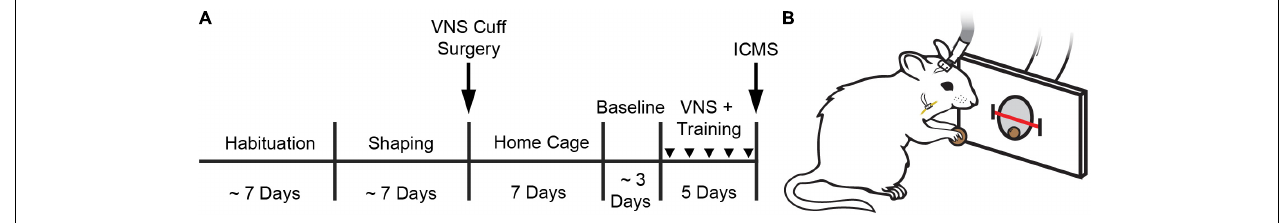
FIGURE 1 | Behavioral task and experimental design. (A) Experimental timeline. (B) Illustration of a rat performing the behavioral task. A stimulating cable plugged into a headmount-connector, the subcutaneous stimulation leads and nerve cuff, and the vagus nerve are shown. A feeder dispenses food pellets into a nosepoke and an infrared beam monitors movement into and out of the nosepoke. Stimulation occurs no faster than once every 8 s. Groups received VNS paired with behavioral training and daily injections of either oxybutynin (Oxy), prazosin (Praz), duloxetine (Dulox), or saline (Veh). Injections were given 1 h before the start of daily training. Injections during training are indicated by downward facing